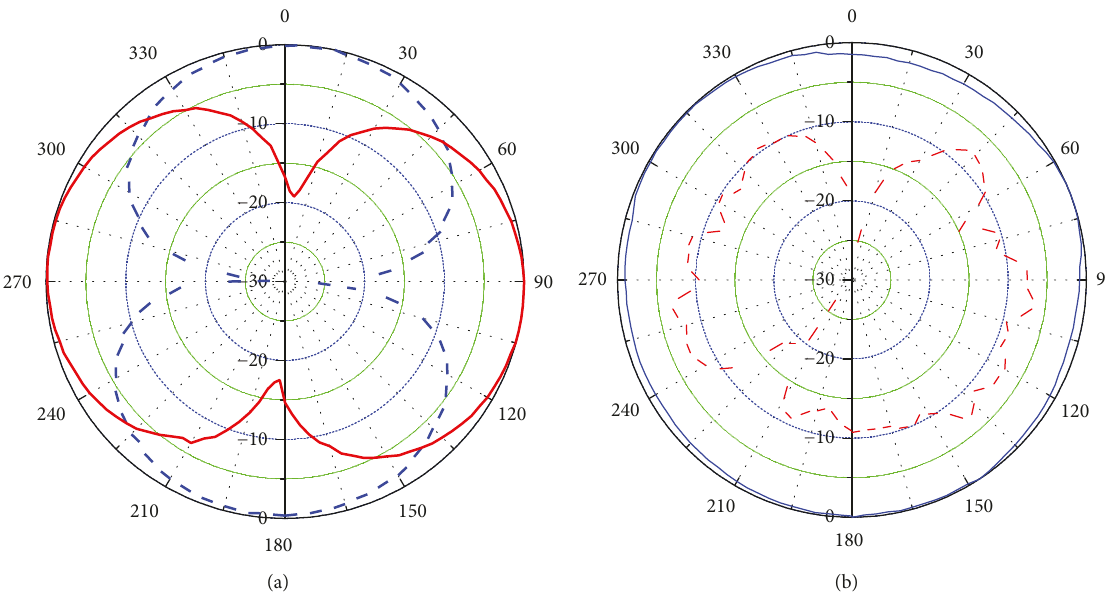
Figure 7: Radiation patterns of the active dipole antennas: (a) E-plane (solid line: y-axis excitation; dashed line: y-axis excitation); (b) H-plane (solid line: copolarization; dashed line: crosspolarization).